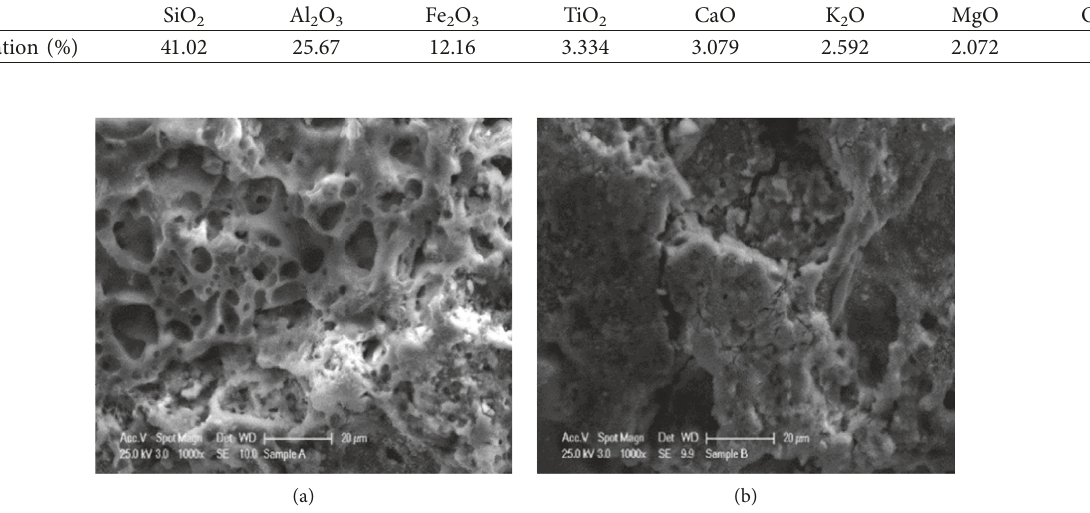
Figure 6: SEM images of Liapor. (a) Liapor before coating. (b) Liapor with the first layer of SiO